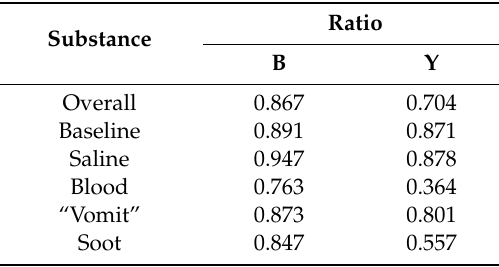
Figure 3. Averaged reflectance spectra at baseline and in the presence of various body fluids for esophageal and tracheal tissues. Table 1. Area under the receiver operator characteristic curves for differentiating trachea from esophagus using Ratio B and Ratio Y.